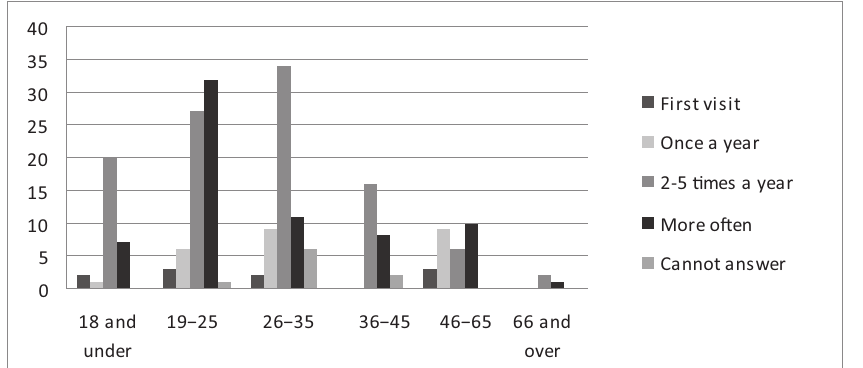
Fig. 8. Correlation between Vilnius festival visits and